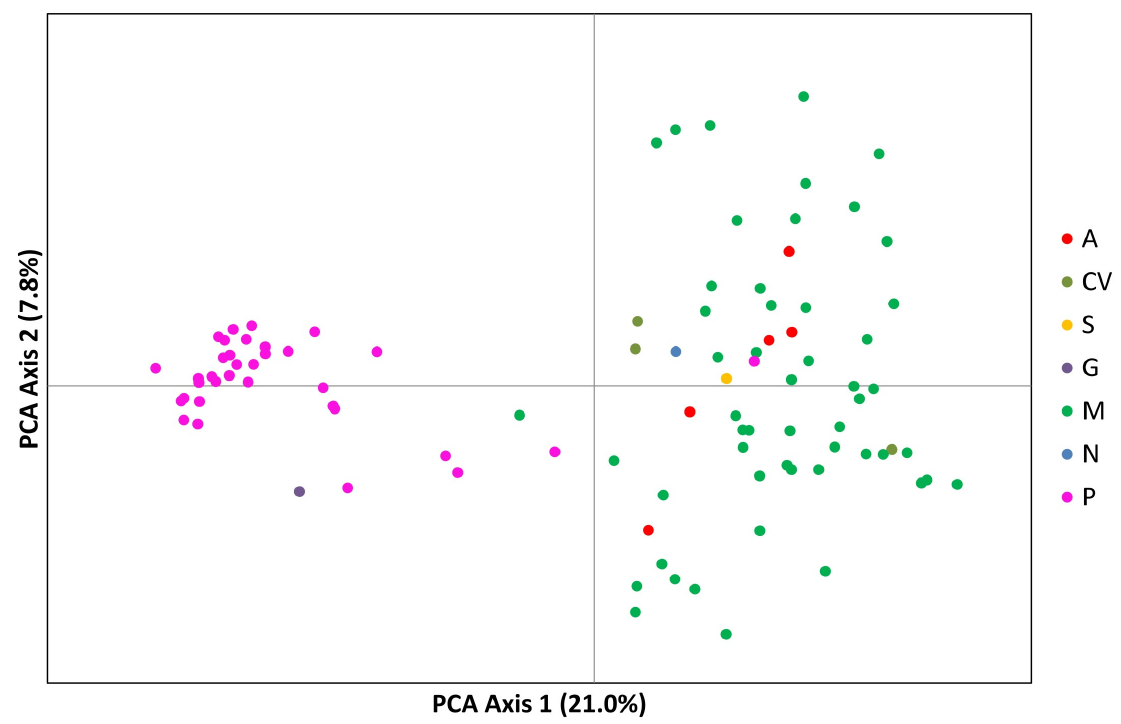
Figure 6. Principal component analysis (PCA) of SSR markers showing allelic variation among 97 cowpea accessions. Dots represent individual accessions grouped by country (red: Angola, olive green: Cape Verde; yellow: Spain; purple: Greece; green: Mozambique; blue: Nigeria and pink: Portugal).